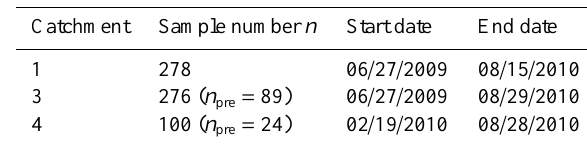
Table 1. Number of total samples for each catchment. Sample size of pre-logging period given in